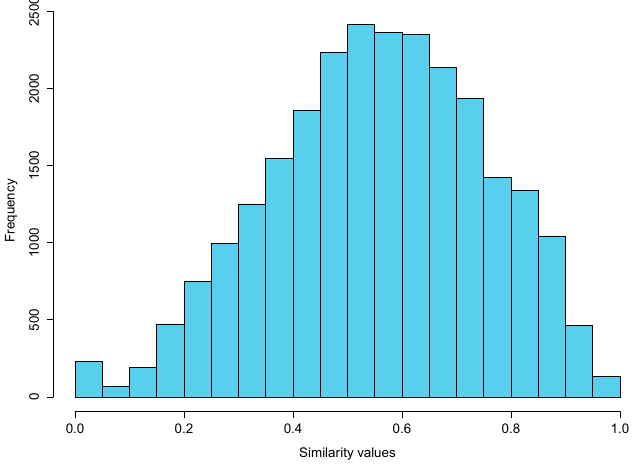
Figure 3. Histogram of values of similarities for the fully connected network.